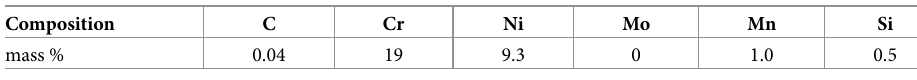
Table 1. Chemical composition (in mass %) of the austenitic 304 stainless steel. Composition